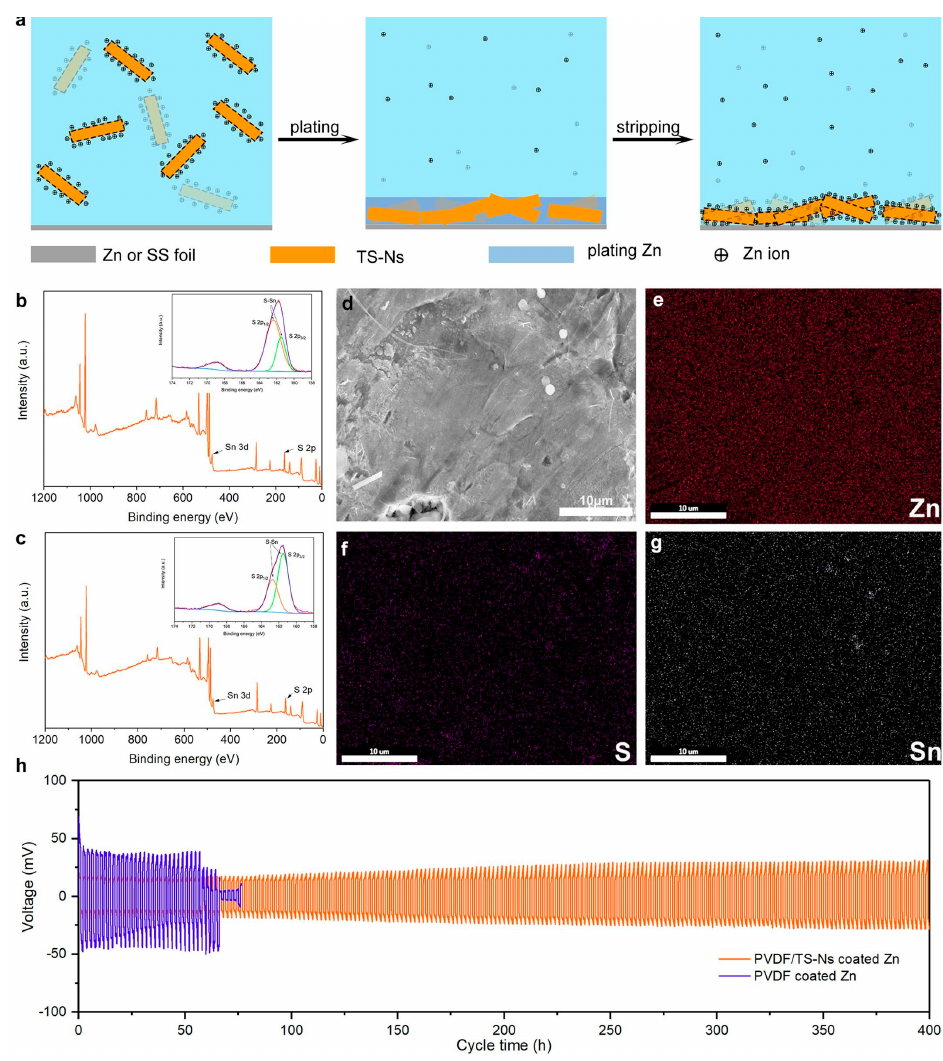
Figure 15. ( a ) Schematic illustration of the working mechanism of TS-Ns participated in the Zn plating/stripping. ( b ) XPS pattern of Zn foil after plating for 0.5 mAh cm − 2 at 0.1 mA cm − 2 . An inset is high resolution XPS spectra of S 2p. ( c ) XPS pattern of Zn foil after plating for 0.5 mAh cm − 2 and then stripping for 0.5 mAh cm − 2 . An inset is high resolution XPS spectra of S 2p. ( d – g ) SEM image and EDX mapping of Zn foil after plating for 0.5 mAh cm − 2 and then stripping for 0.5 mAh cm − 2 . ( h ) The voltage profiles of the symmetric cells composed of the PVDF/TS-Ns-coated Zn and the PVDF-coated Zn at 1 mAh cm − 2 and 1 mA cm − 2 . Reproduced with permissions from Ref. [108]. Copyright © 2022 Elsevier Ltd.